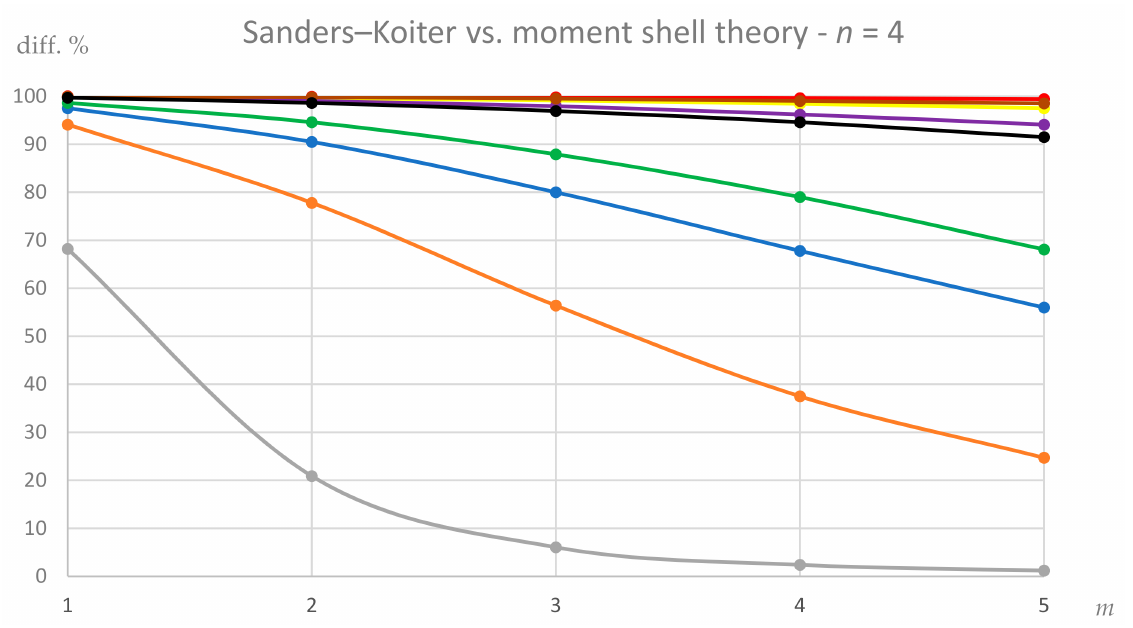
Figure 9. Simply supported DWCNT of Table 1 with different values of aspect ratio L / R 2 and thickness ratio R 2 / h . Shell-like modes ( n = 4). Comparisons between extended Sanders–Koiter and simplified moment shell theories, where